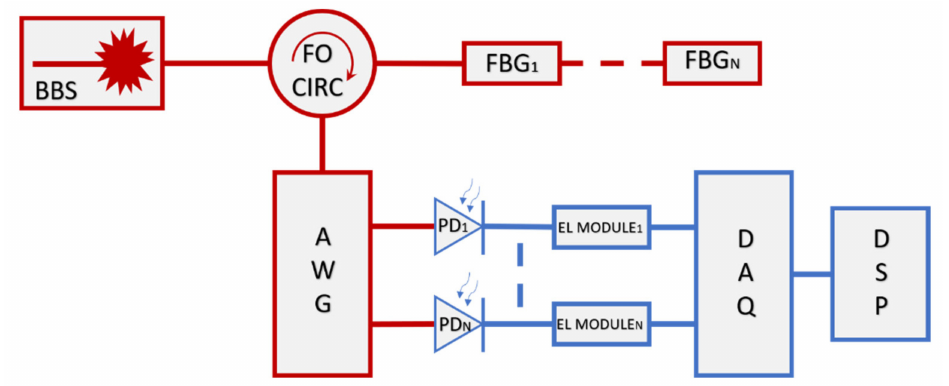
Figure 1. Block schematic about the proposed concept. The red lines describe the optical part, while the blue lines describe the electrical